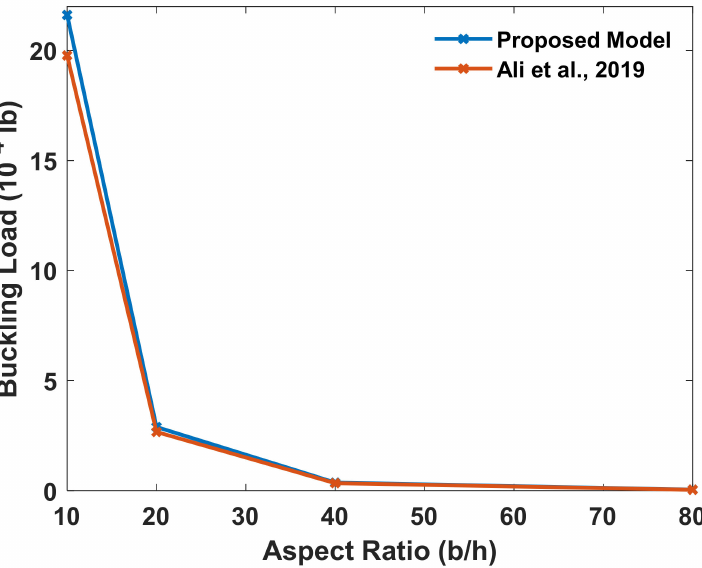
Figure 6. Percentage difference between the proposed model and [30] for different aspect